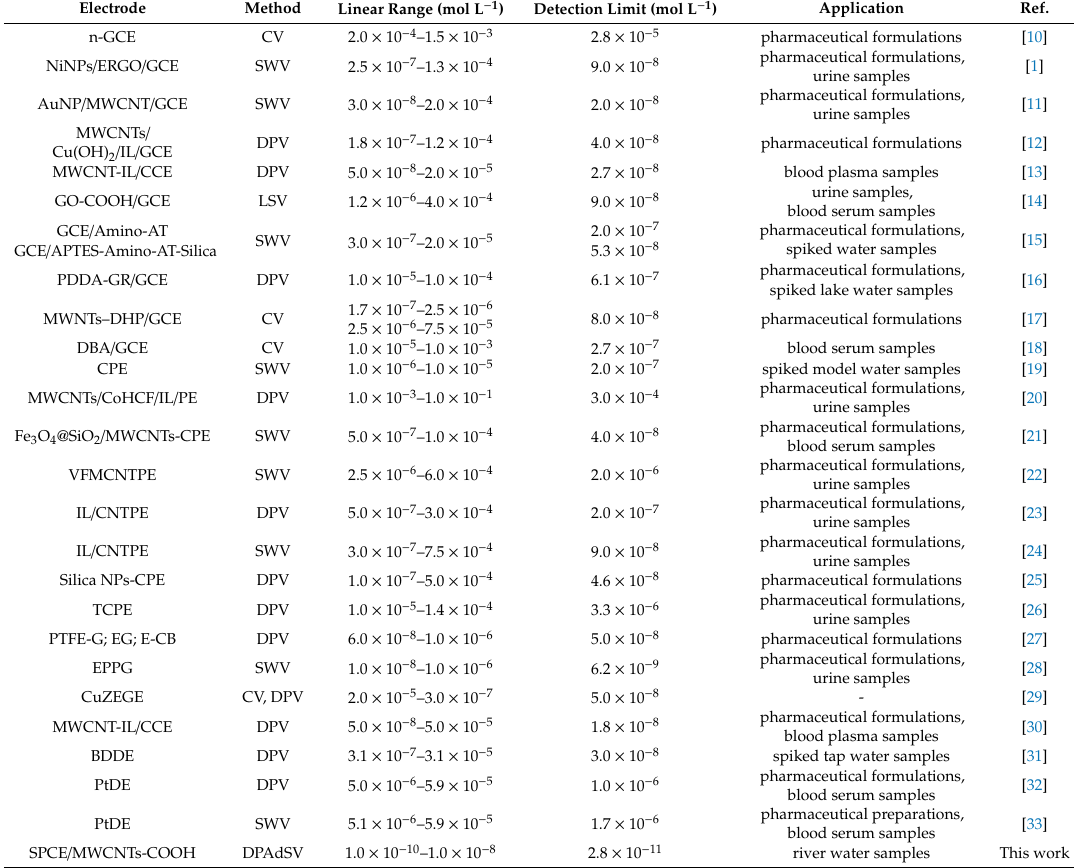
Table 3. Comparison of electrochemical methods for the determination of